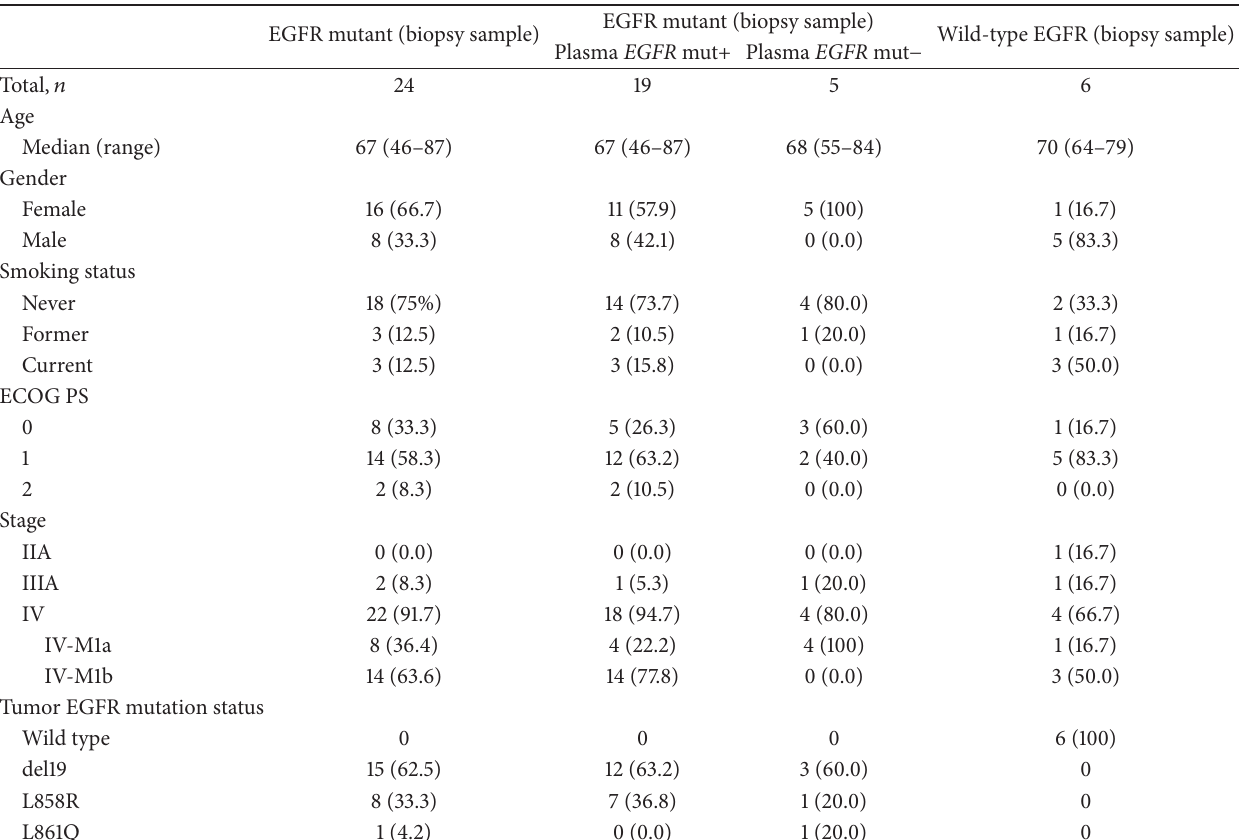
Table 1: Patients’ characteristics.